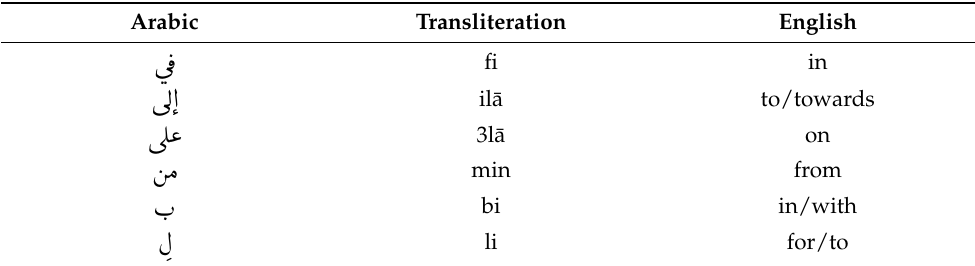
Table 1. Prepositions in Arabic, transliteration, and the usual translation into